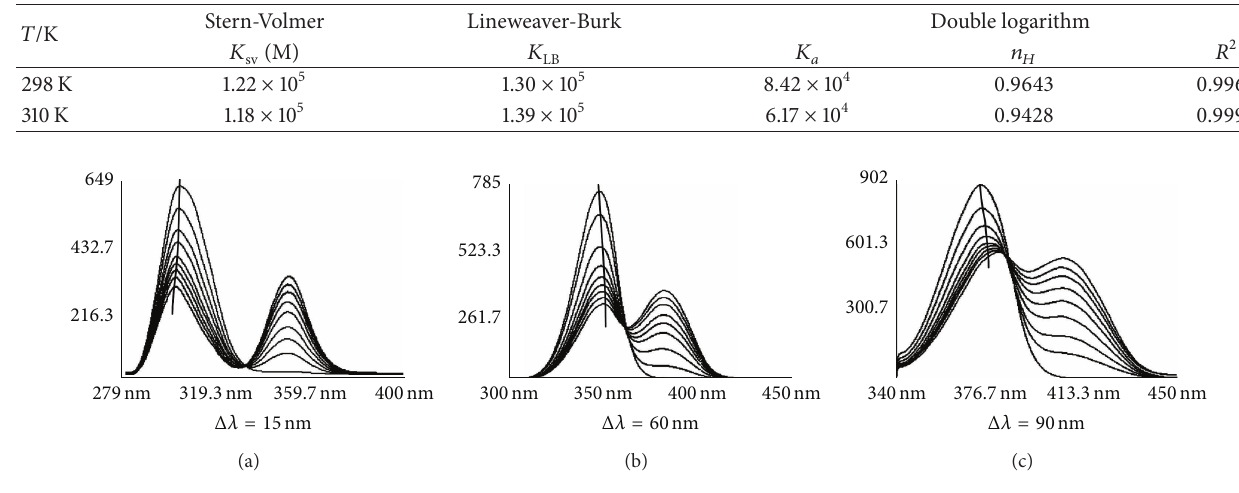
Figure 7: Synchronous fluorescence spectra of interaction between HSA and warfarin.